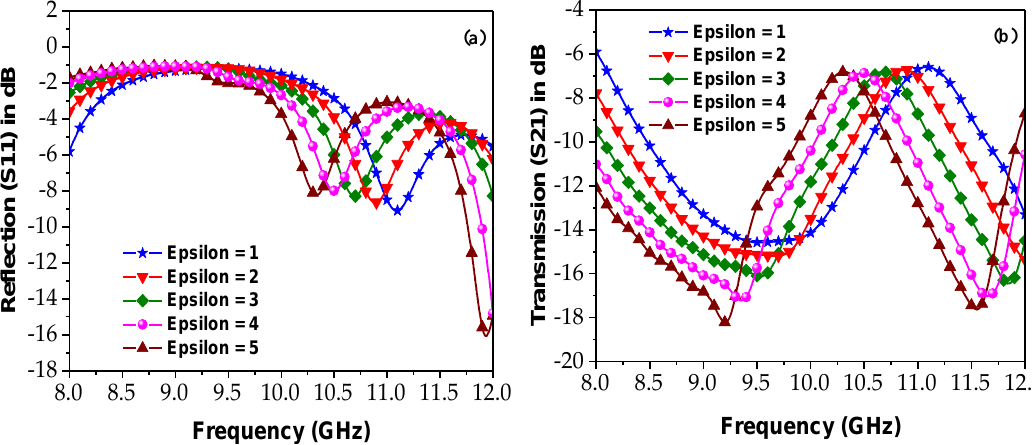
Figure 7. ( a ) Effect of epsilon variation of the sensor layer on the resonant frequency and amplitude in the reflection spectrum and ( b ) transmission spectrum.